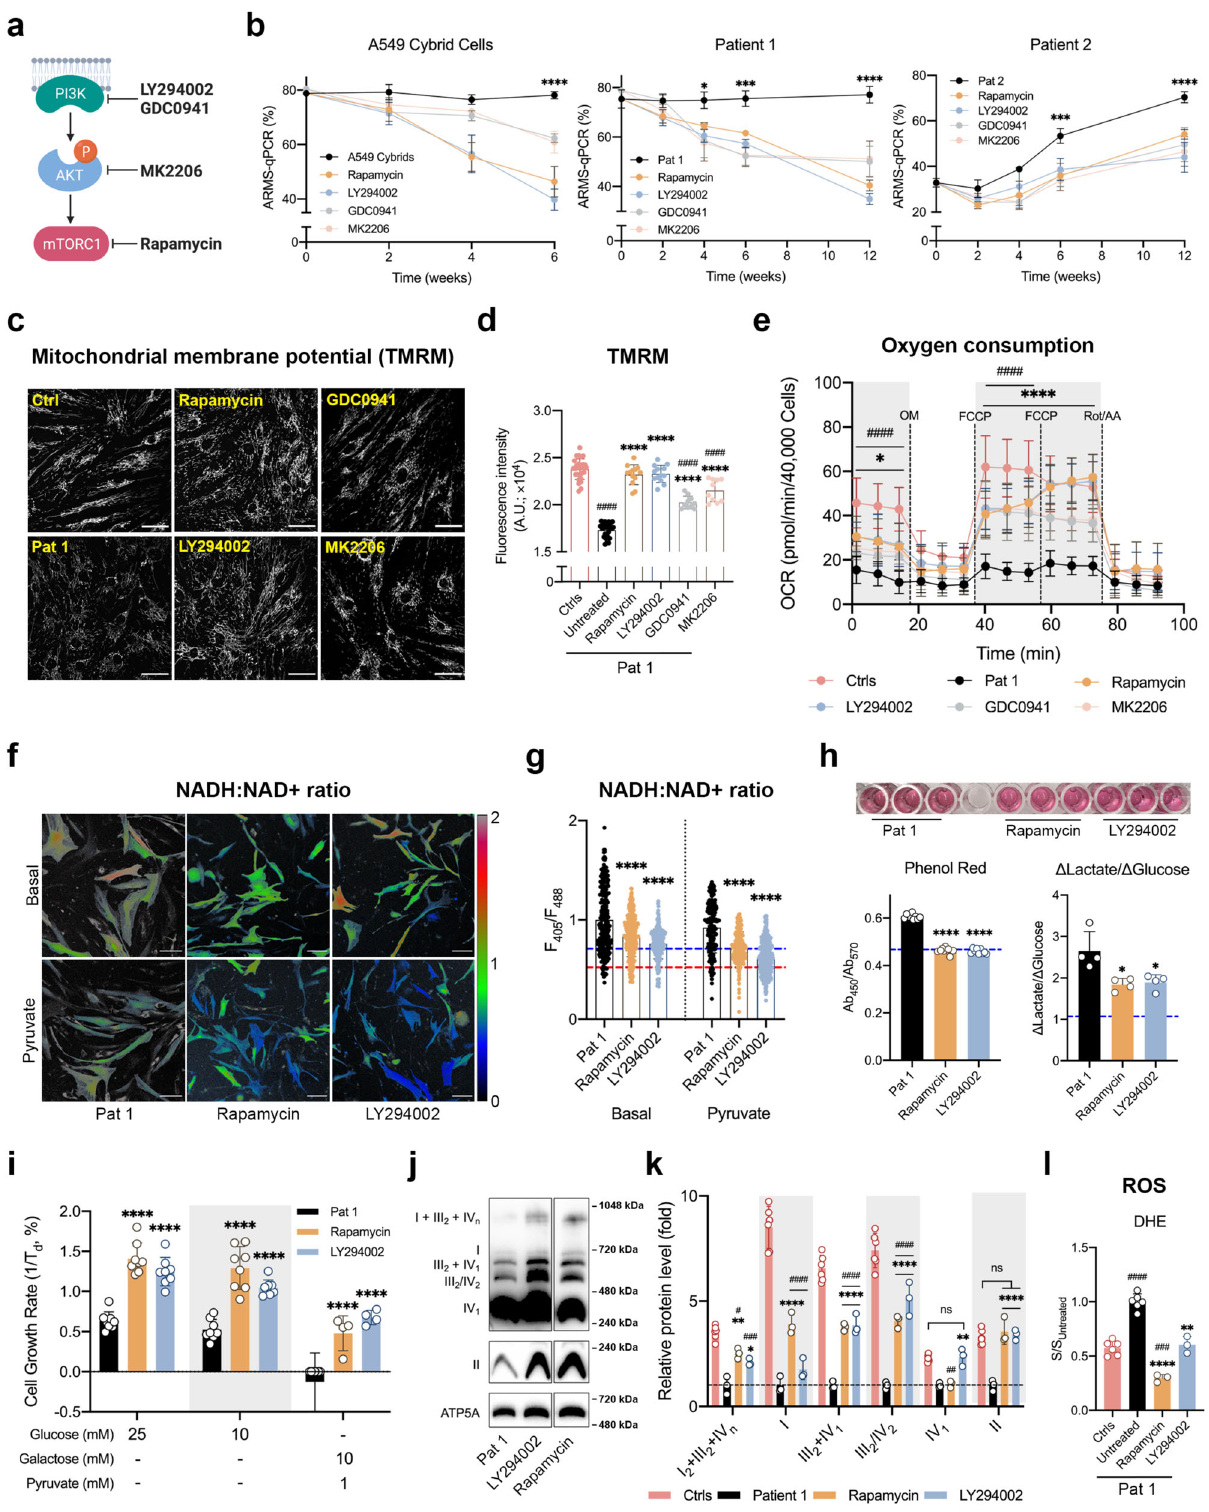
( ‘ treatment ’ ). Although treatment with either LY or RP sig- ni fi cantly slowed cell proliferation in both fi broblast and cybrid cells at the time point of 0-week pretreatment (Fig. 6b, upper panel), the changes were small. The cell growth rate was stable in cybrid cells treated with LY or RP, suggesting that there was no clonal expansion. In fi broblasts, growth rates of cells were not altered by LY but increased by RP after 4-week pretreatment.